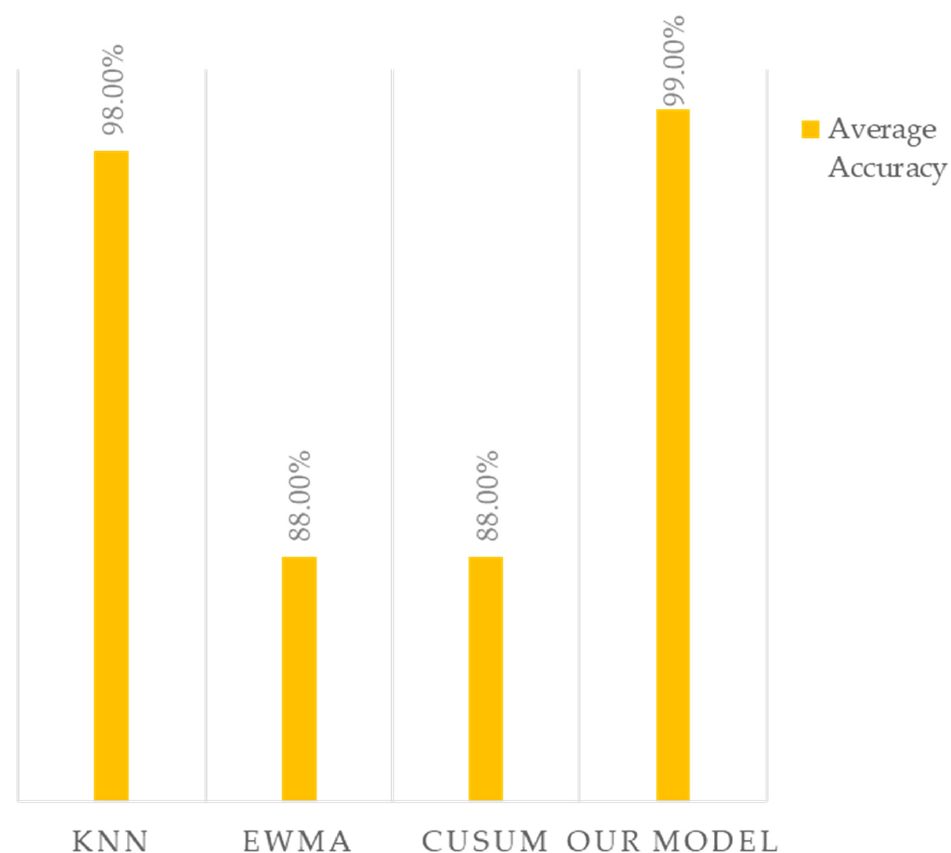
Figure A8. Comparison of the accuracy of EWMA, CUSUM, and KNN with our model.